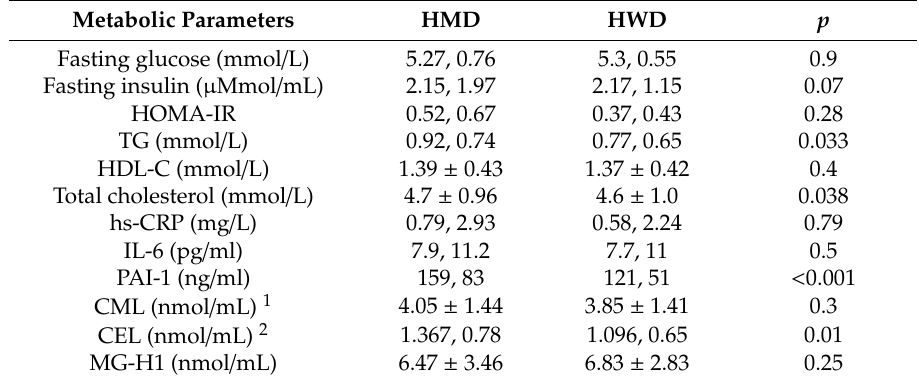
Table 2. Insulin sensitivity, lipids, inflammatory and fibrinolytic markers, and AGEs measured at the end of each dietary period in all participants ( n =